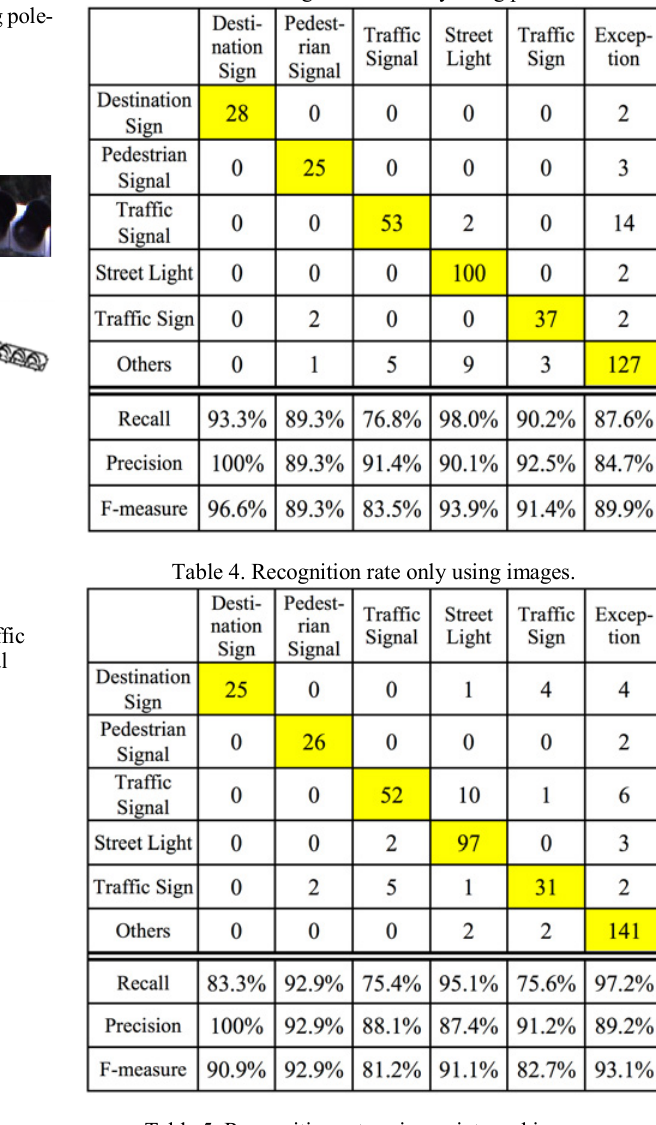
Table 3. Recognition rate only using points.